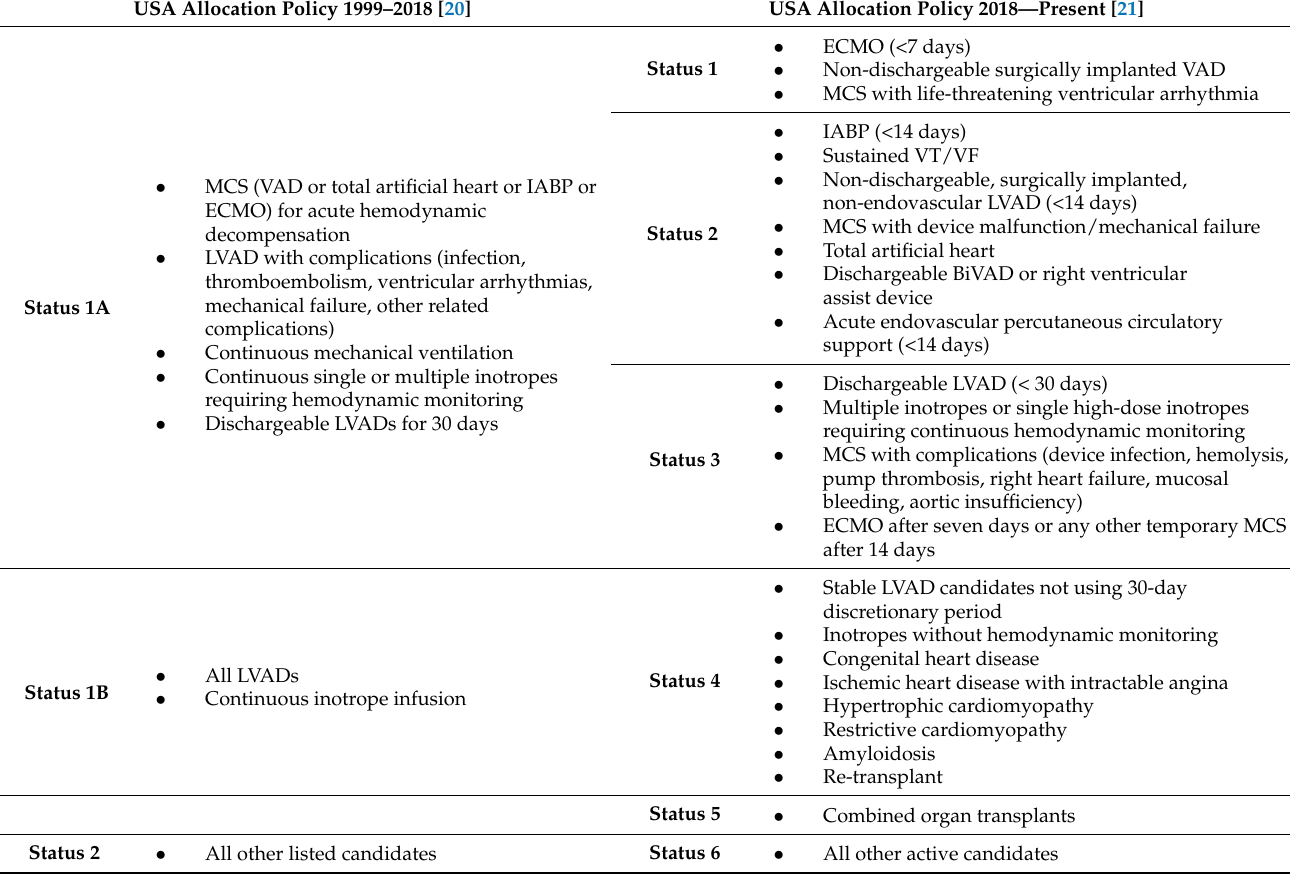
Table 2. The differences between the old and new allocation system in the